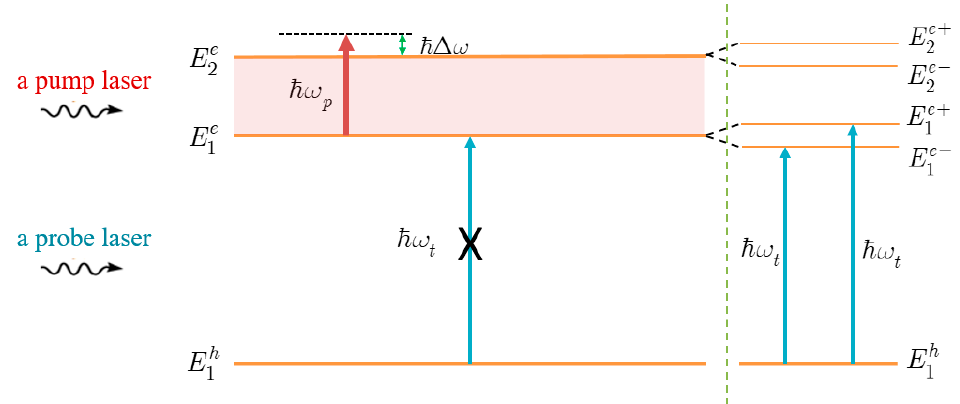
Figure 3. The splitting diagram of electron energy levels caused by a strong pump laser, resonant with two electron levels.